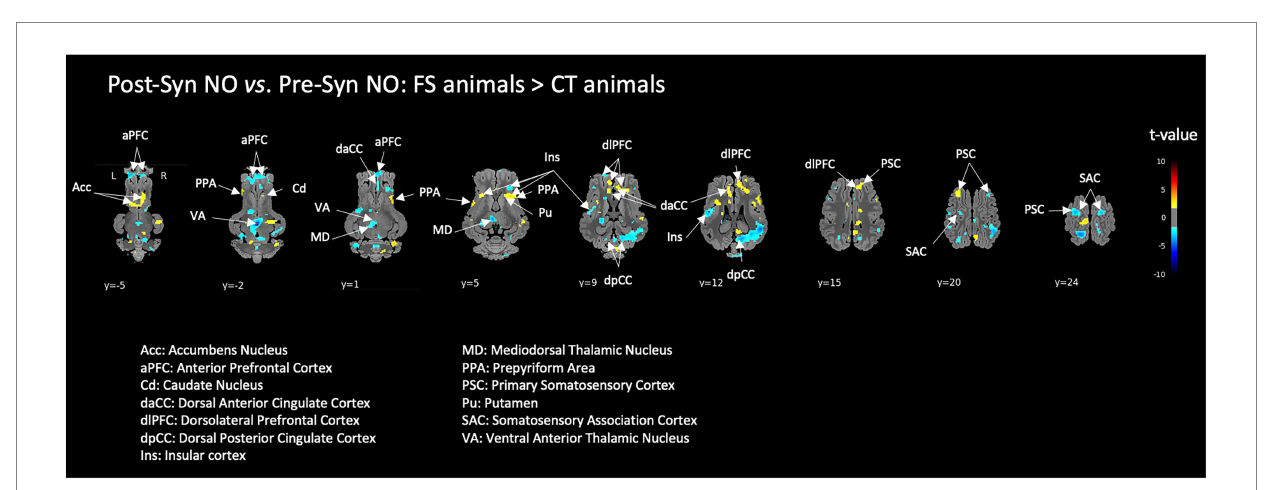
FIGURE 6 Effect of previous chronic exposure to the functional food ingredient on the brain responses to a pharmacological acute stress. Brain responses of FI-habituated animals (FS) were compared to those of control animals (CT), ‘after – before’ the acute stress (i.e., Post-Syn – Pre-Syn). BOLD responses during the stimulation with non-odorized air (NO) were used for this comparison. Horizontal maps of brain BOLD responses are represented at different dorsal-ventral levels ( y ) related to the posterior commissure (in mm). Value of p threshold = 0.05, k > 20 (number of voxels per